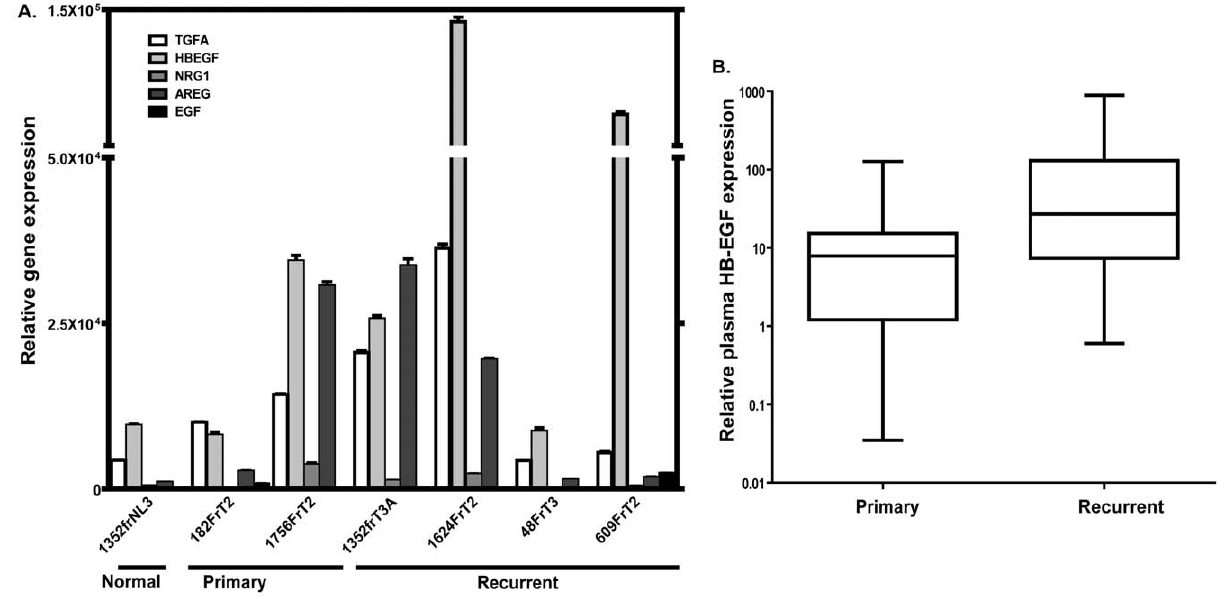
Figure 6. The HB-EGF levels in patients with HNSCC. A) Relative expression levels of five ligands in one normal oral mucosa and six tumors from patients with HNSCC. B) HB-EGF protein levels in plasma from patients with HNSCC. ‘‘Primary’’ plasma samples were taken at the time of diagnosis. ‘‘Recurrent’’ samples were taken at the time of recurrence.